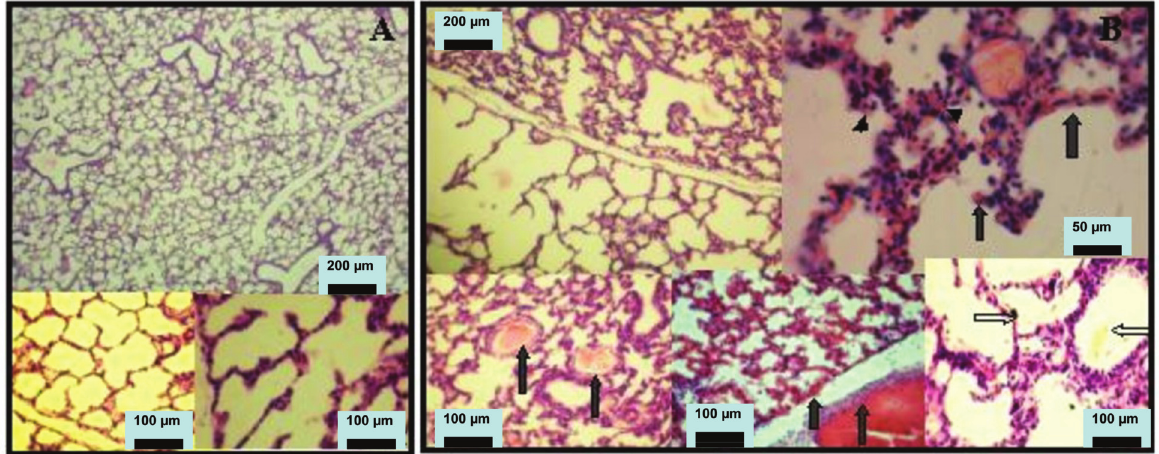
Figure 5. A , Sections of control lungs and, B , histological images after meconium instillation into the airway. Open arrows indicate vascular congestion or the presence of meconium in the alveolar lumen, and filled arrows indicate polymorphonuclear neutrophils and congestive